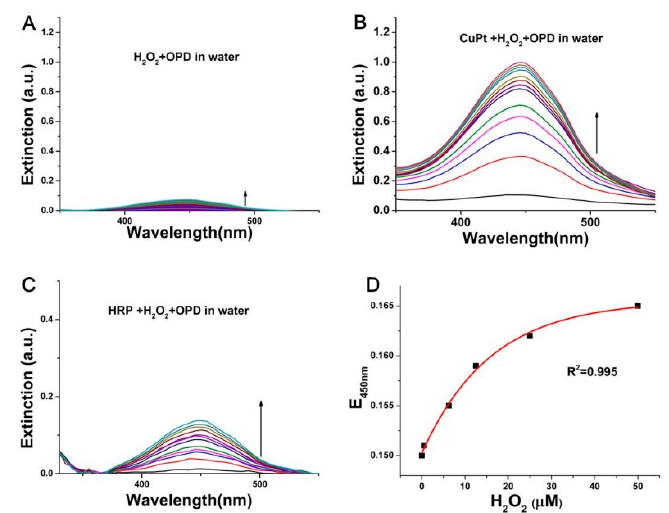
Figure 3. Peroxidase (POD)-like activity of CuPt in water and its application in detection of H 2 O 2 concentrations. The time-dependent changes of UV-Vis-NIR spectra with ( A ) or without ( B ) the addition of CuPt measured by every 2 min. UV-Vis-NIR spectra were collected in water containing 4.60 mM OPD and 0.50 M H 2 O 2 for 30 min. ( C ) UV-Vis-NIR spectra of horseradish peroxidase (HRP) oxidize OPD in the presence of H 2 O 2 for every 1 min. [HRP] = 2.3 nM, [OPD] = 4.60 mM, and [H 2 O 2 ] = 0.50